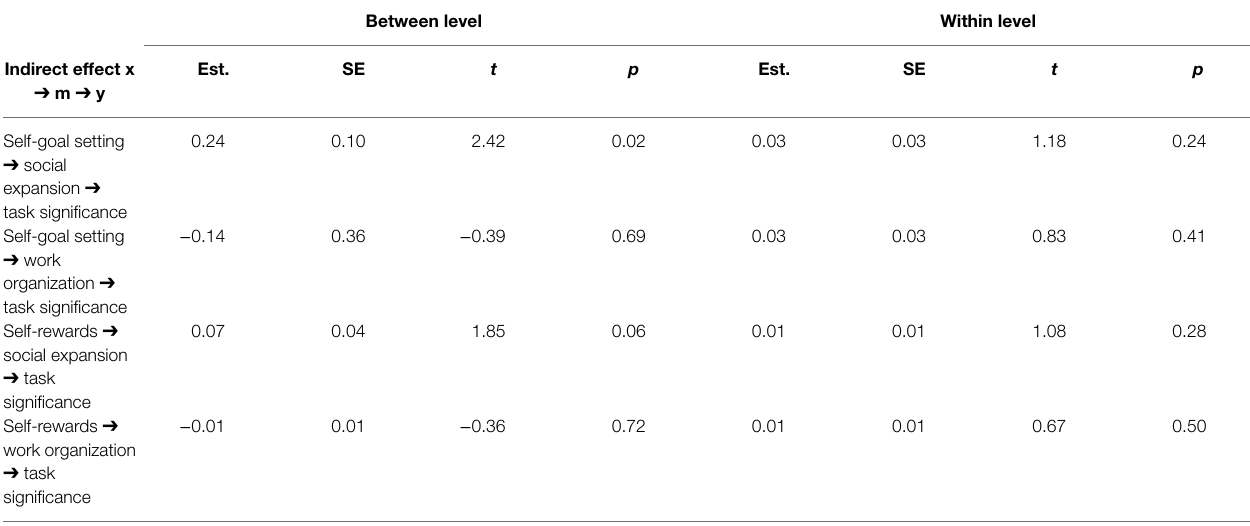
TABLE 5 | Indirect effects of self-leadership on task significance via job crafting. Between level Within